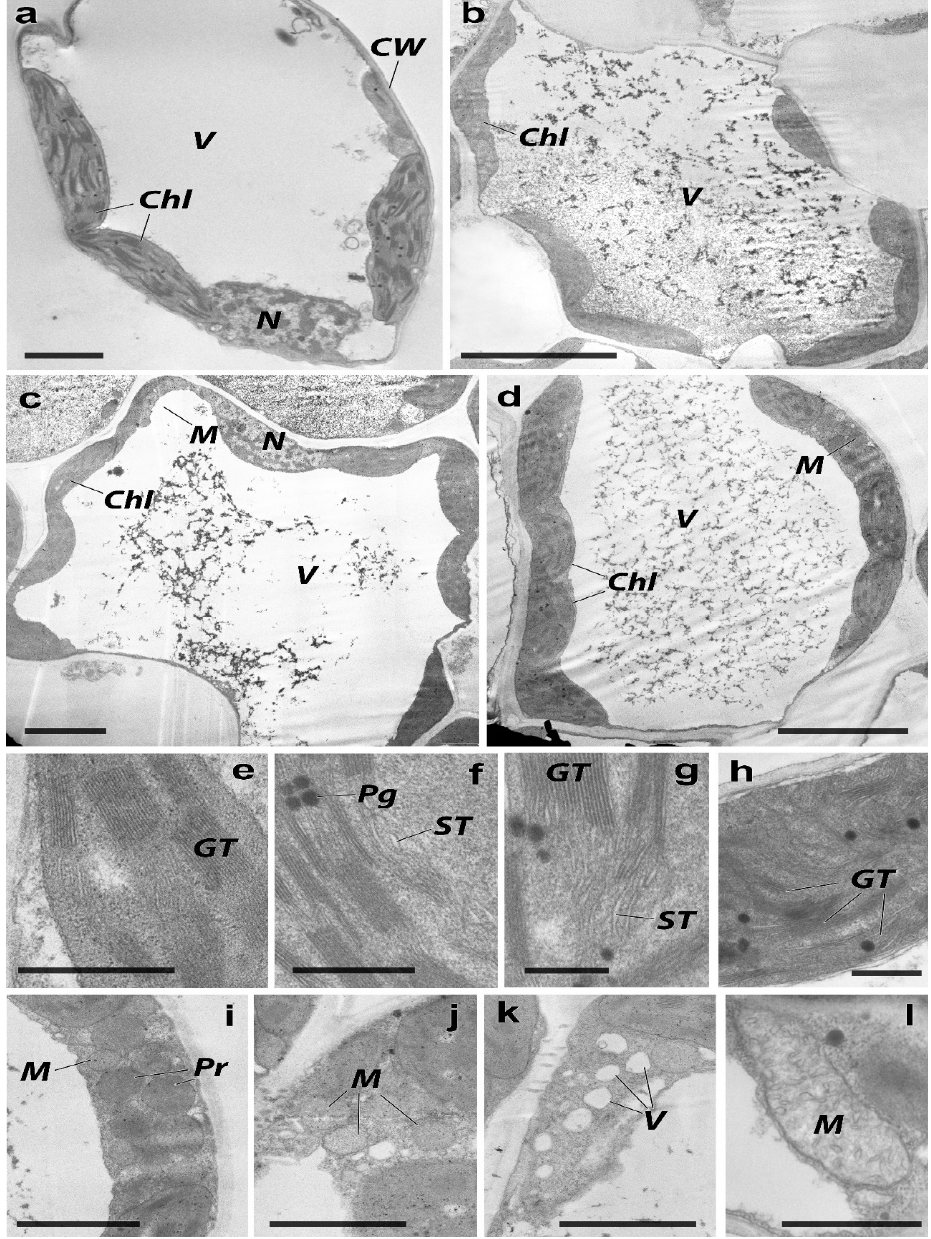
Figure 5. TEM images of H. vulgare leaf chlorenchyma. ( a , e )—control, ( b , f , j )—treatment with 1100 mg/kg of Zn, ( c , g , k )—treatment with 10 mg/kg of Cd, ( d , h , i , l )—treatment with combined contami- nation of 1100 mg/kg of Zn + 10 mg/kg of Cd. M—mitochondria, CW—cell wall, Chl—chloroplast, Pg—plastoglobuli, GT—granal thylakoids, ST—stroma thylakoids, N—nucleus, M—mitochondria, Pr—peroxisome, V—vacuole. Scale segment (µm): a-2, b-5, c-5, d-5, e-0.5, f-0.5, g-0.3, h-0.5, i-2, j-2, k-2, l-1.